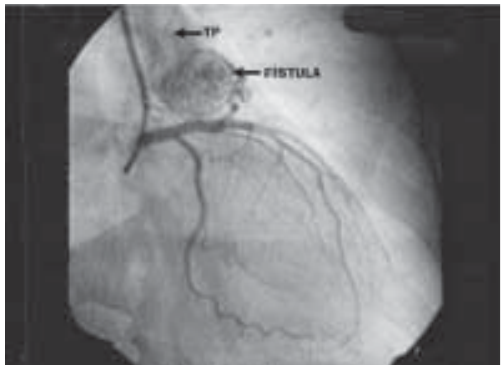
Fig. 1A - Pre-operative angiography demonstrating a left coronary artery fistula to the pulmonary branch (TP) (case 3).